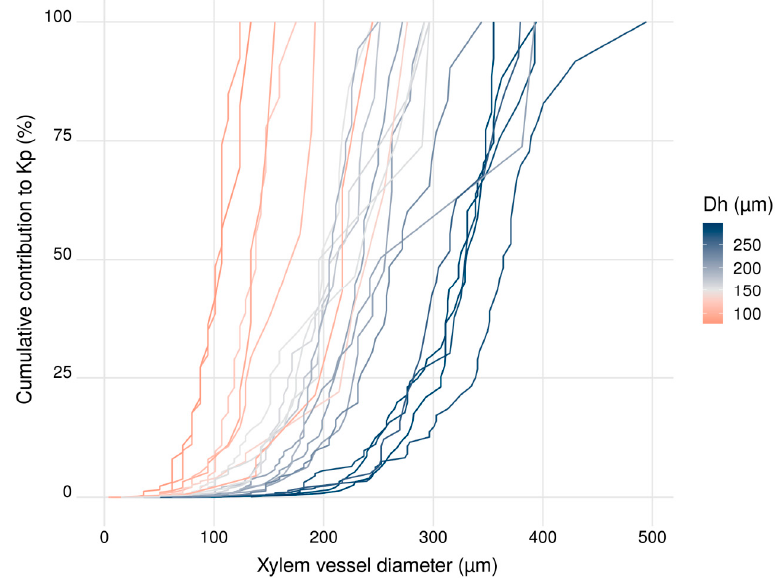
Figure 3. Contribution to the maximum stem hydraulic conductivity of each xylem vessel according to its diameter. All 22 studied individuals were ranked, and hence colored according to their hydraulically-weighted diameter D h .